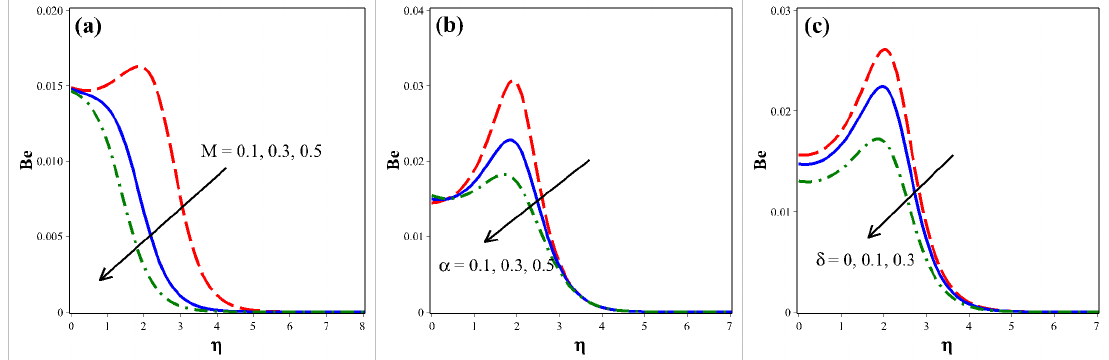
Fig. 7: Influence of magnetic parameter , second grade parameter and thermal slip on Bejan number Be .